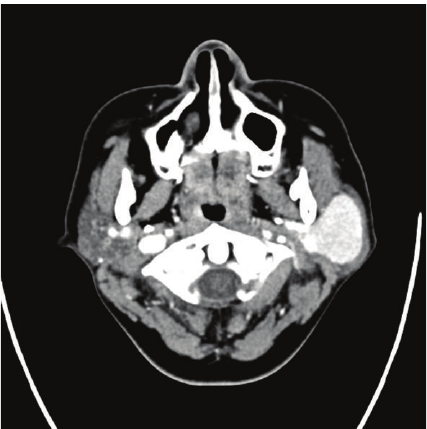
Figure 1: CT head and neck axial cut, after contrast, soft tissue window: a well-defined, oval shaped solid lesion involving the left superficial lobe of the parotid gland. The lesion shows a diffuse intense enhancement after IV contrast media injection.